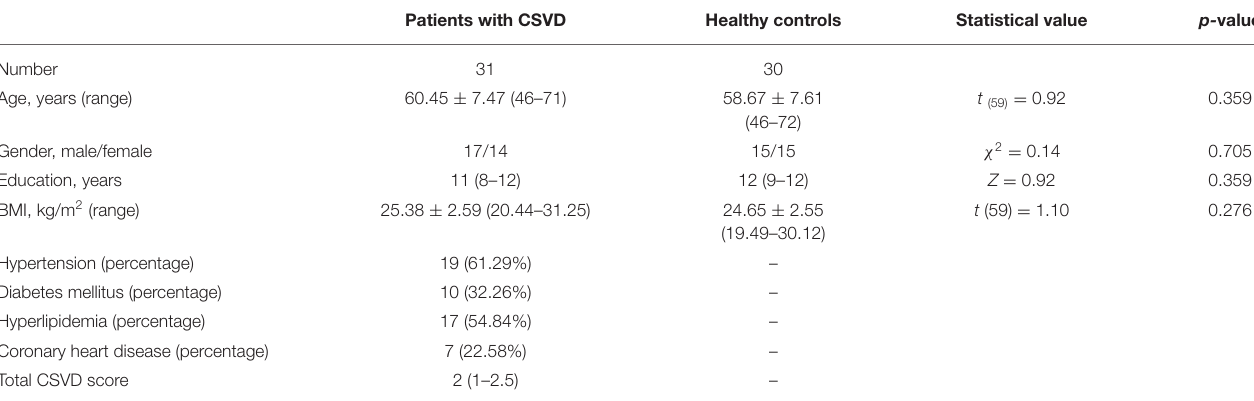
TABLE 1 | Demographic, clinical, and imaging characteristics of patients with CSVD and healthy